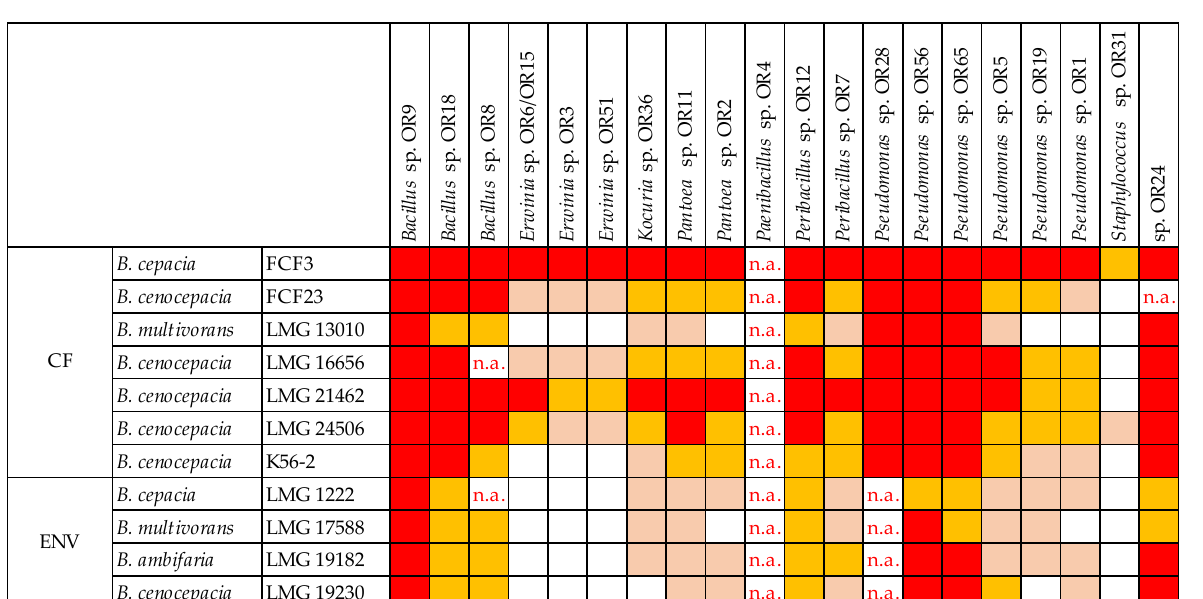
Figure 11. Antagonistic interactions of O. heracleoticum seed-associated strains against Bcc strains. The degrees of inhibition observed are indicated as red (complete), orange (strong), salmon (weak) and white (absence of inhibition). n.a. (not available) refers to results that were not obtained.